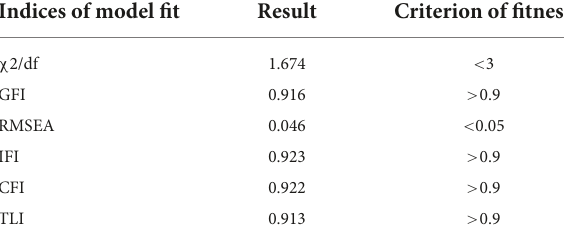
TABLE 5 The degree of model fit.